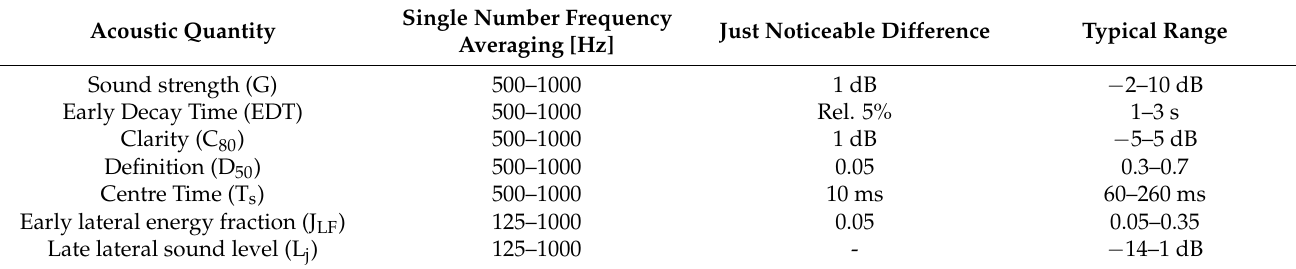
Table 4. Acoustic parameters for the evaluation of the listener aspects